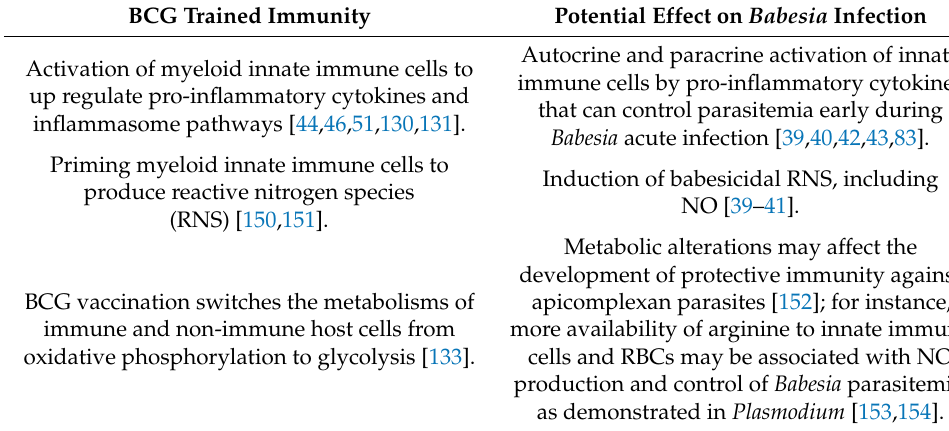
Table 1. BCG trained immunity and its potential effects on Babesia